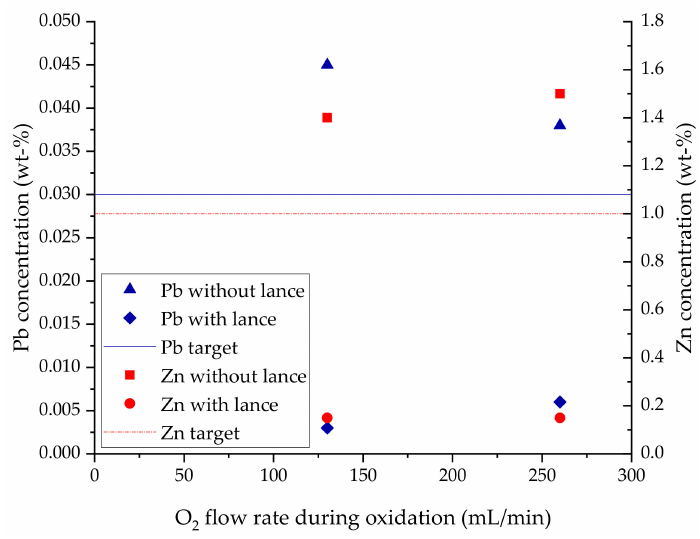
Figure 5. Lead and zinc concentrations in the bulk samples after oxidation-reduction experiments, as a function of oxygen flow rate (130 or 260 mL/min) during the oxidation stage. The effect of the gas lance is quite